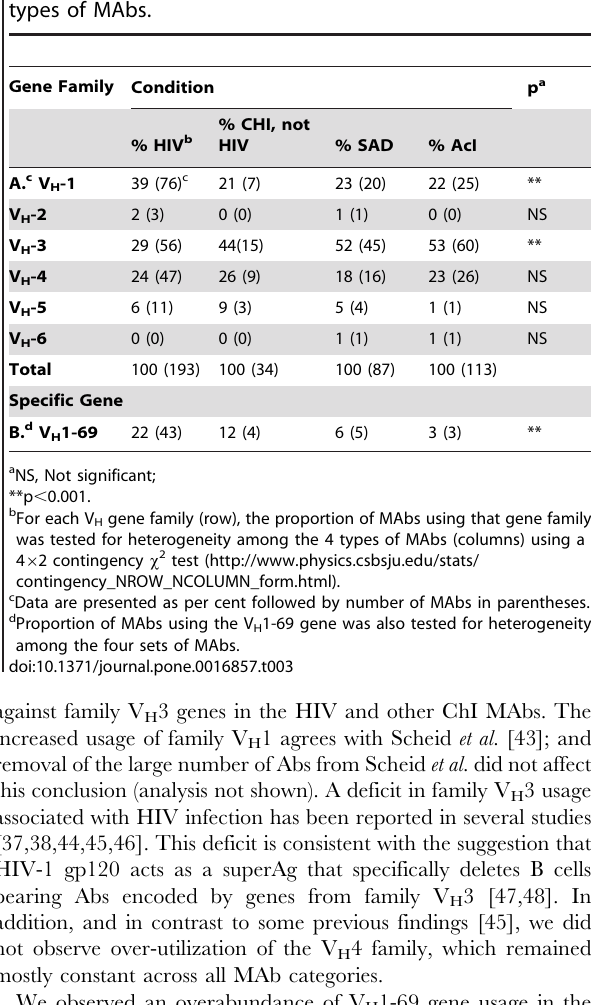
Table 3. V H gene family and V H 1-69 gene usage among 4 types of MAbs.